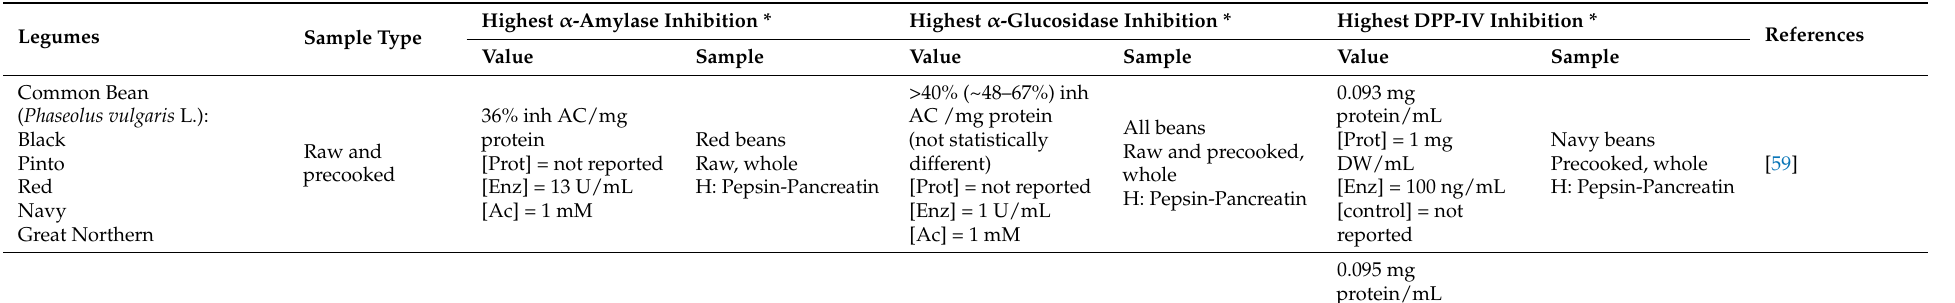
Table 1. In vitro studies on antidiabetic leguminous protein hydrolysates and